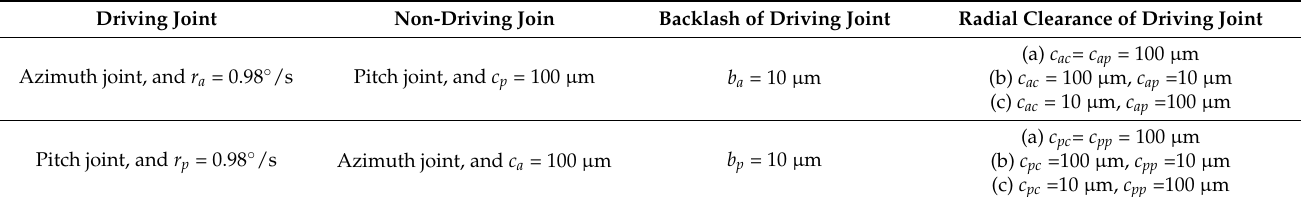
Table 3. Simulation parameters of radial clearance.